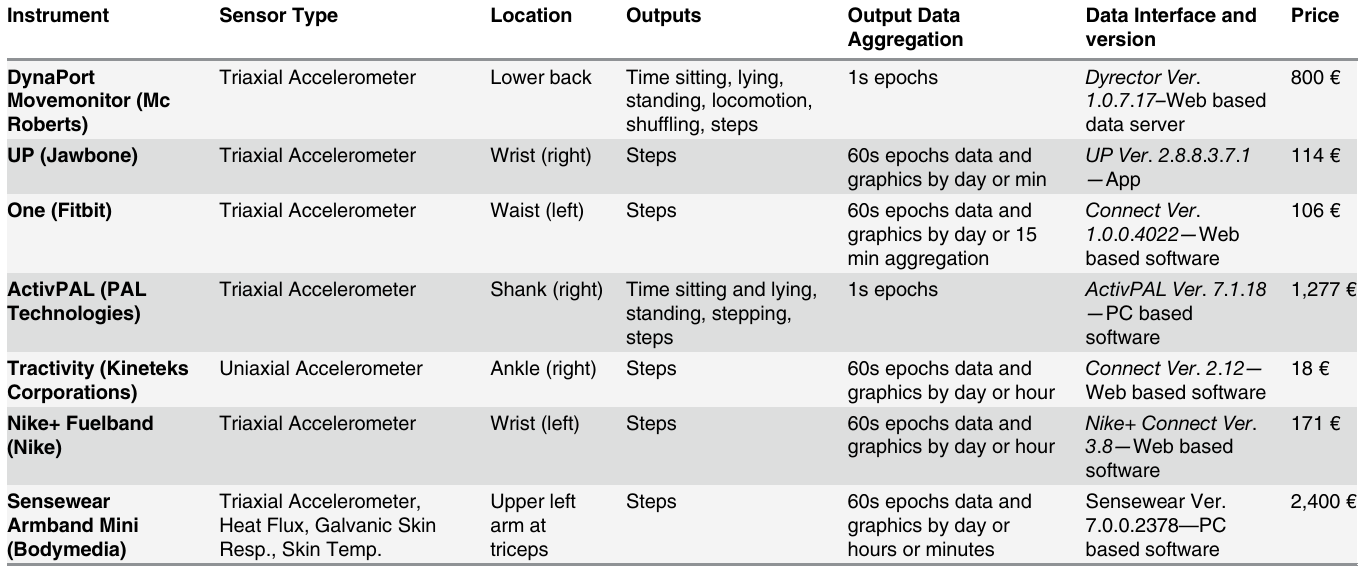
Table 2. Details of the monitors tested in this